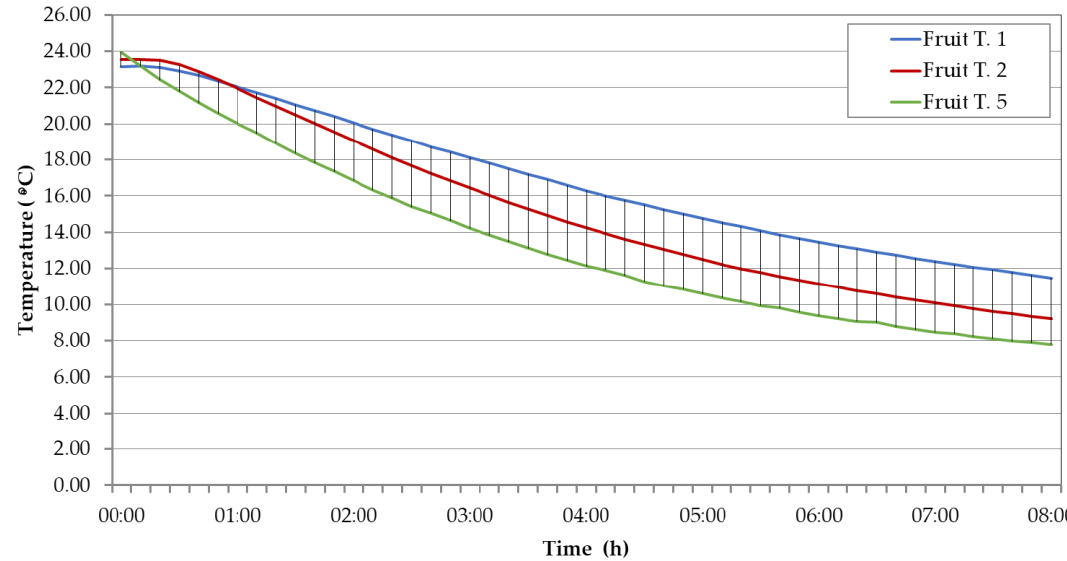
Figure 8. Thermal behavior of configuration B, packages 1 to 3.